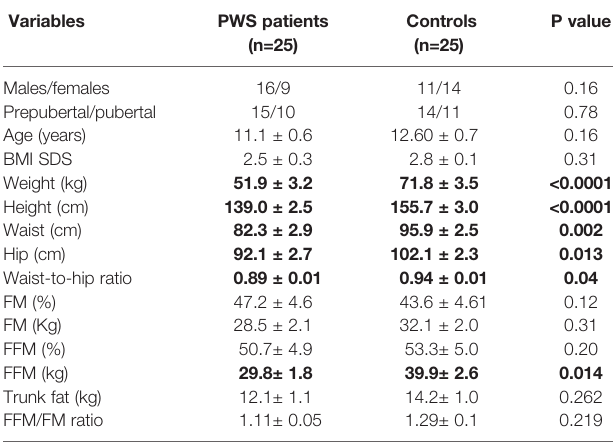
TABLE 1 | Summary of anthropometric data obtained in PWS patients and controls. Variables